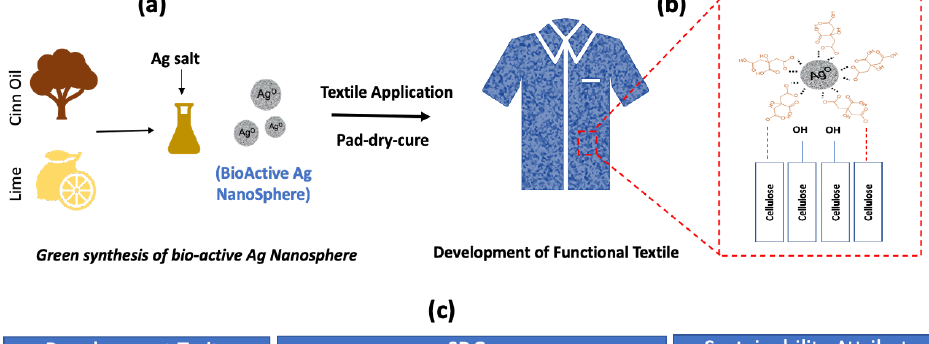
Figure 7. Measurement of fabric easy-care performance and tear strength as an impedance of cross- linking: ( a ) comparison of crease recovery angle value; ( b ) comparison of crease recovery angle value; ( c , d ) SEM images of fabric treated with Ag@CINN and Ag@CINN-Lim, respectively (yellow arrows point out the nanoparticles whereas white arrows point out the textile fibers).